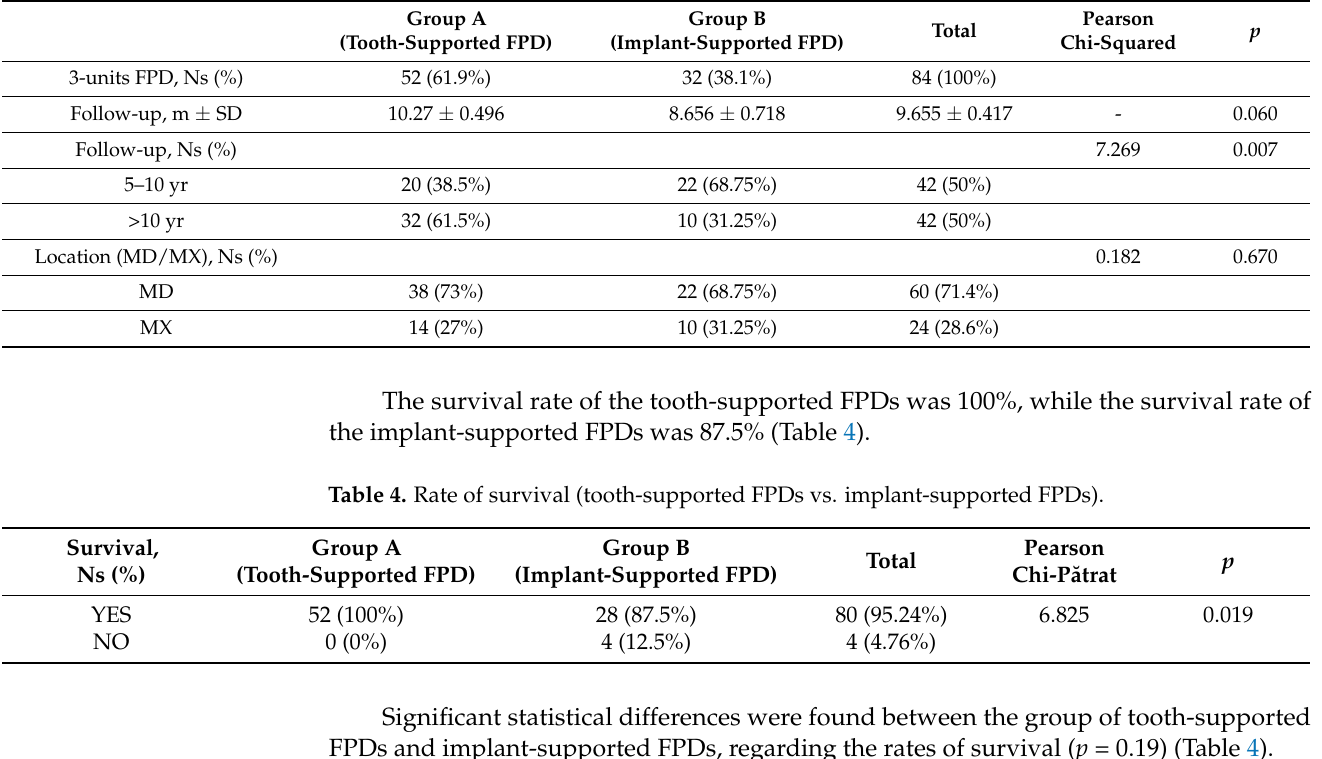
Table 3. Features of the study groups by FPD (tooth-supported FPD vs. implant-supported FPD).